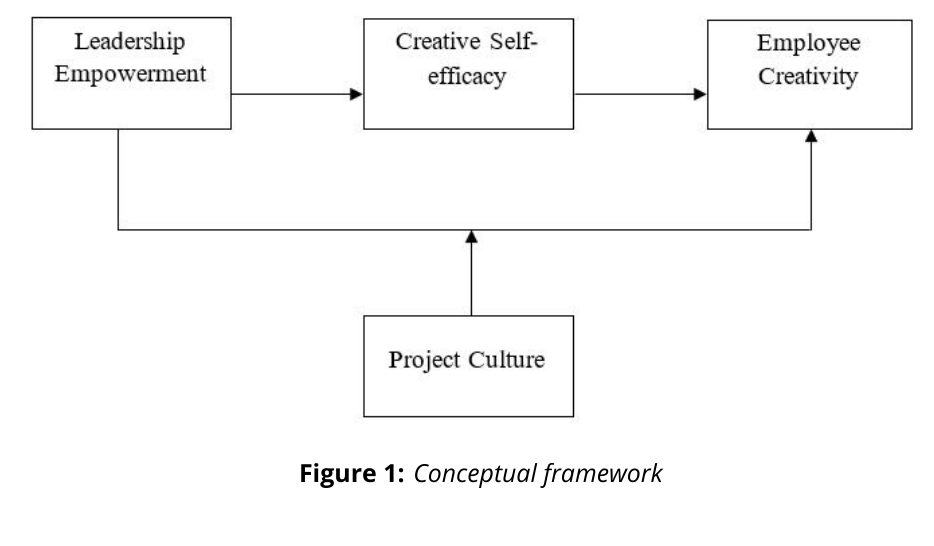
Figure 1: Conceptual